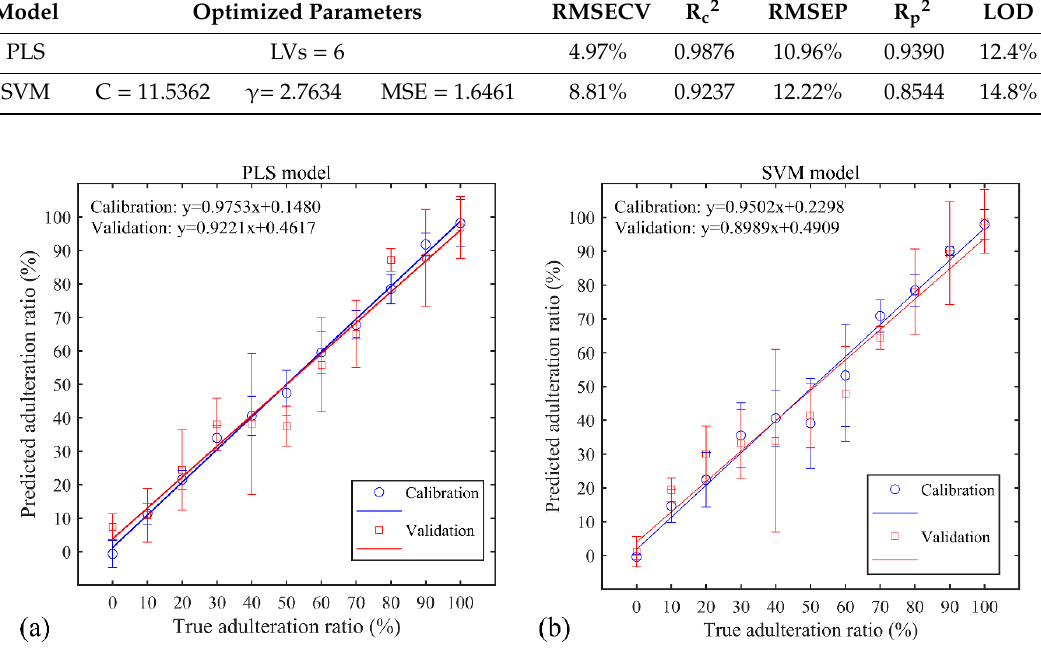
Figure 7. Calibration plots of the predicted adulteration ratio and true adulteration ratio in the ( a ) PLS model and ( b ) SVM